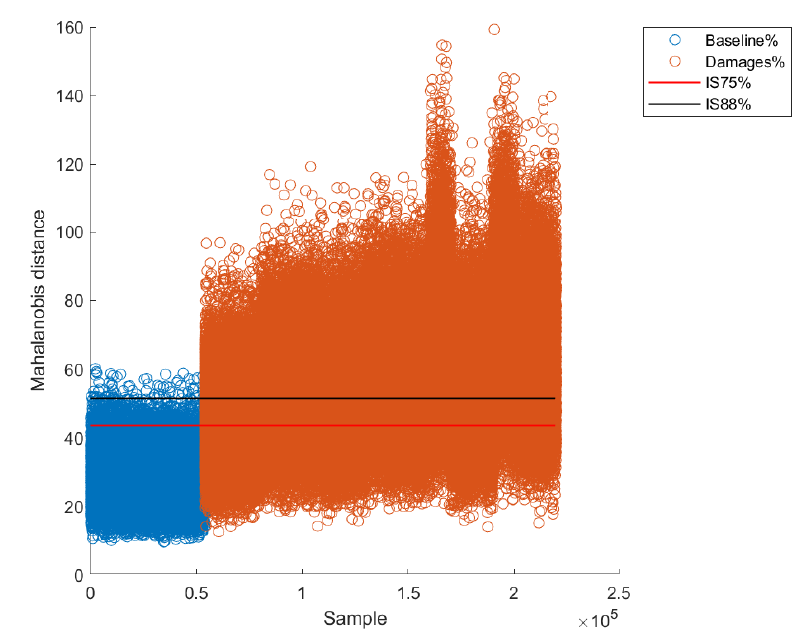
Figure 15. Confidence intervals for excitation frequency of 16.25